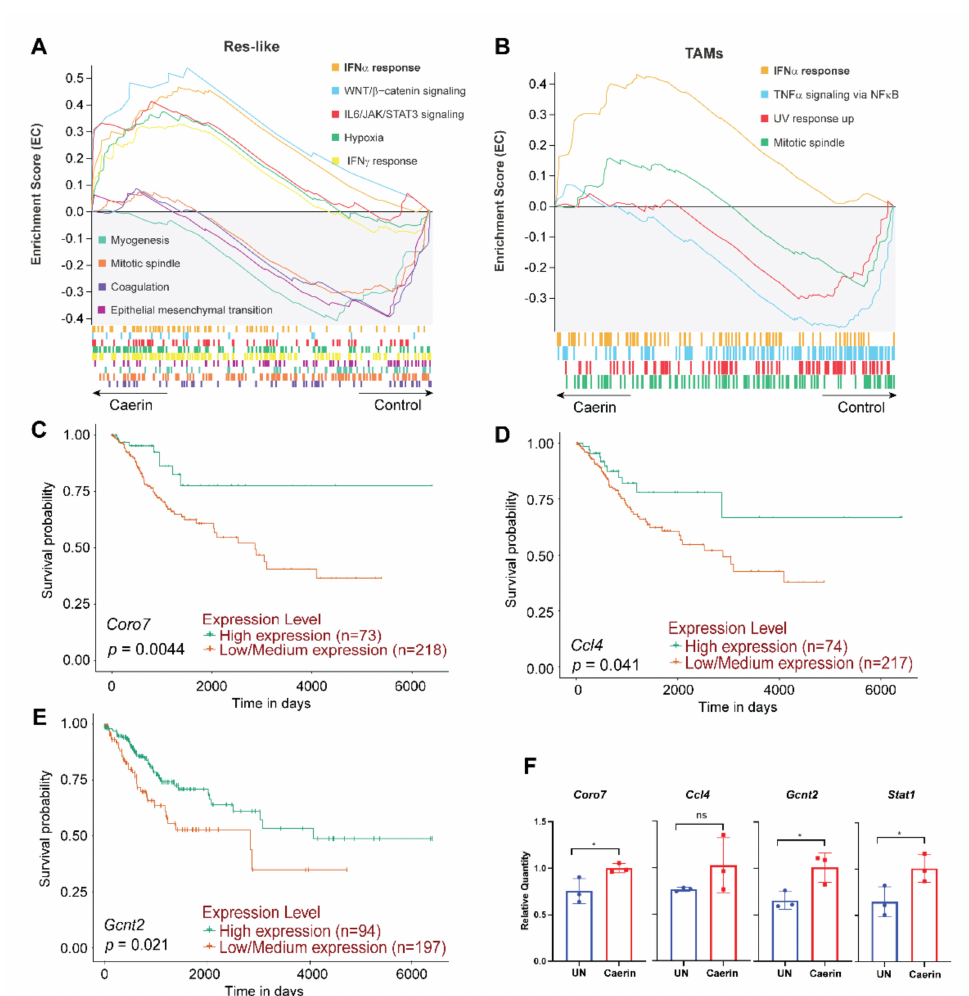
Figure 3. Macrophage phenotypes are regulated by the topical application of the gel containing caerin 1.1/1.9. Enrichment of signalling pathways in resident-like macrophage ( A ) and TAMs ( B ) of the caerin group relative to the control group predicted by GSEA analysis of the data published previously [29]. The correlation between survival curves of cervical squamous cell carcinoma and the expression of selected genes identified in (Figure S2E) derived from the TCGA data portal, including Coro7 ( C ), Ccl4 ( D ), and Gcnt2 ( E ). ( F ) Comparison of the expression of Coro7 , Ccl4 , Gcnt2 , and Stat1